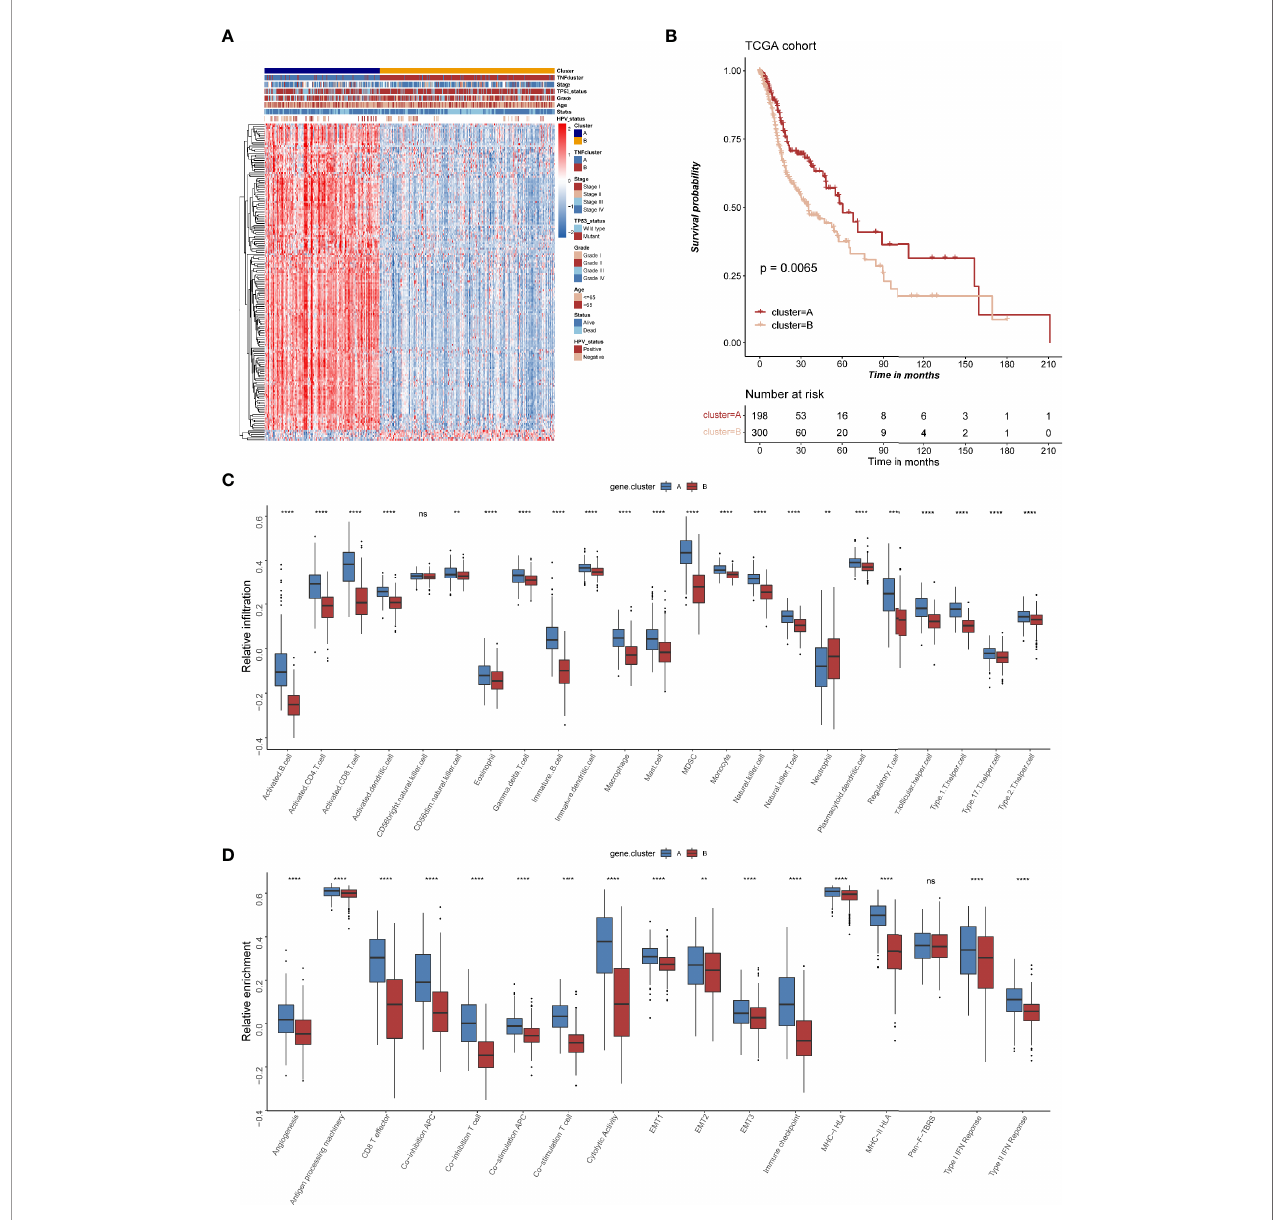
FIGURE 5 | The clinical and transcriptomic characteristics of TNF-related gene clusters. (A) Unsupervised clustering of 177 TNF related genes in TCGA HNSCC cohort. Red represents high expression, and blue represents low expression. The TNF gene cluster patterns, TNF patterns, HPV status, TP53 status, stage, pathological grade, age, and survival status were used as sample annotations. (B) Kaplan-Meier survival analysis of two TNF gene cluster patterns in TCGA HNSCC cohort. (C) Relative in fi ltration of 23 types of immune cells in TNF gene cluster A and B (D) Relative enrichment score of 17 immune related signatures in TNF gene cluster A and B. ( ** p < 0.01, **** p < 0.0001, ns, not signi fi